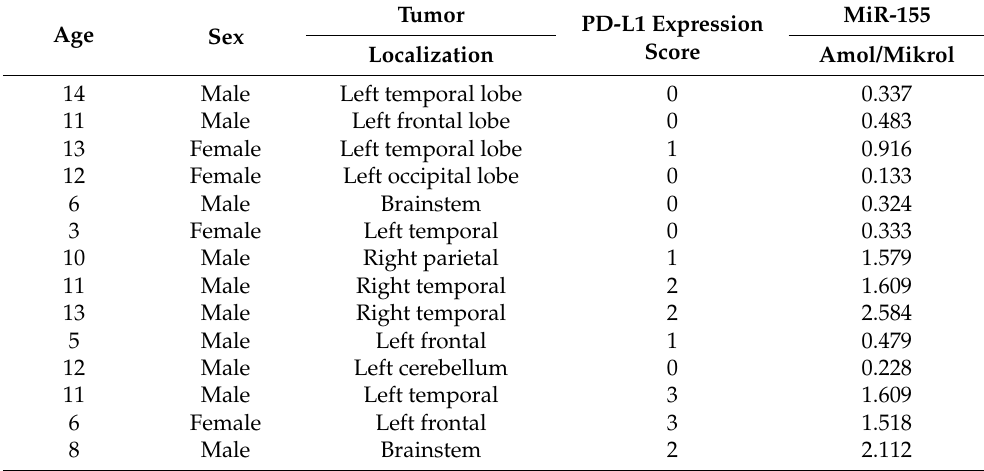
Table 3. Molecular status of PD-L1 expression and miR-155 expression in several patients with p-HGG